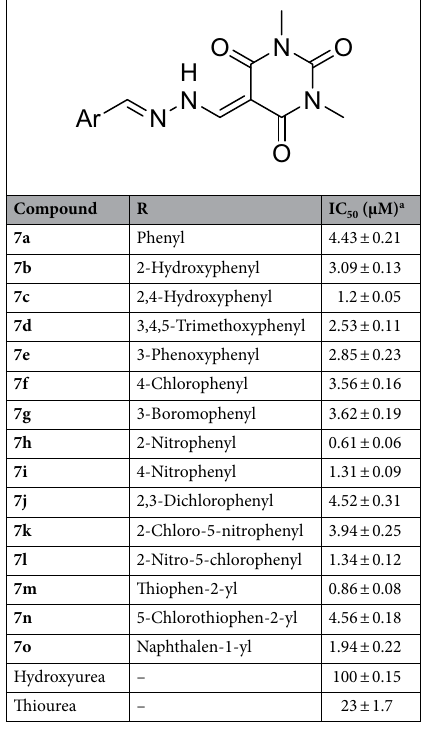
Table 1. The IC 50 values (μM) of compounds 7a–o against urease. a Values are the mean ± standard error of the mean. All experiments were performed at least three